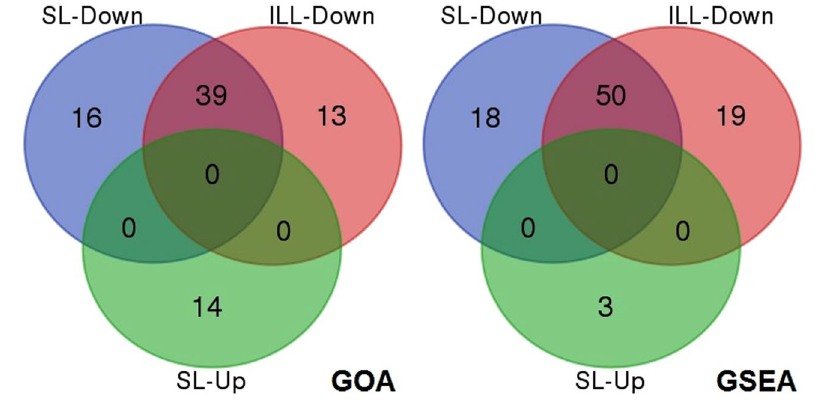
Figure 5. Venn diagrams showing the overlap between SL-Seq or ILL-Seq of GO sets found downregulated (Down) or upregulated (Up) with GOA (left) and GSEA (right). Note: For both methods, no upregulated GO sets were found for